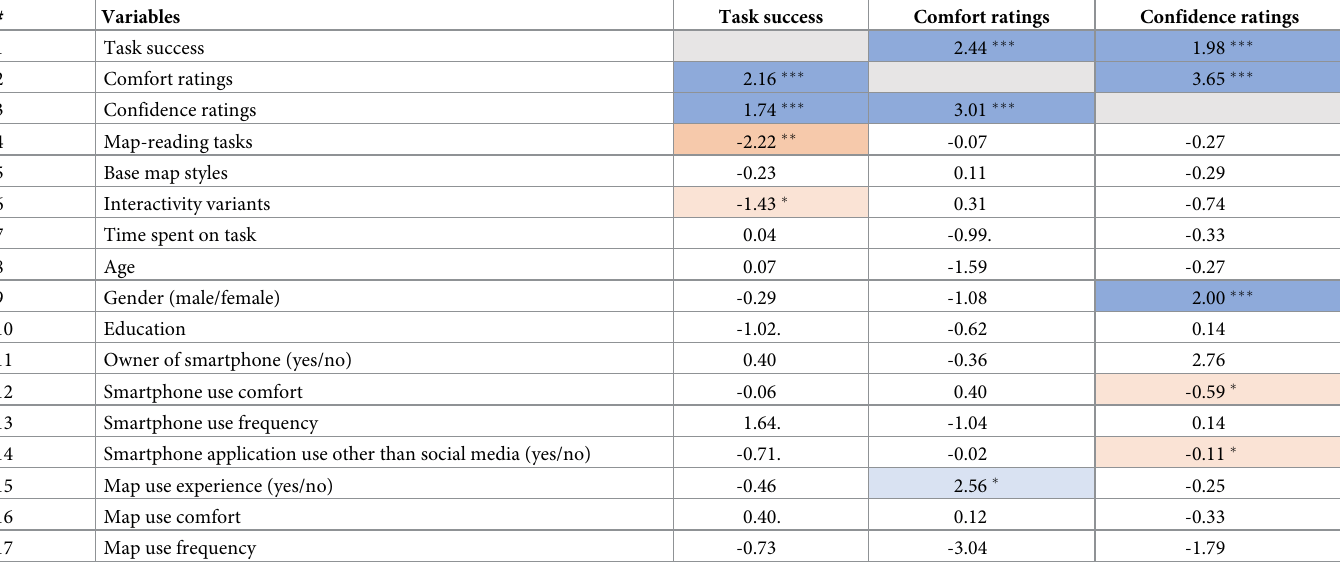
Table 6. Regression models with SBC and p-value with task success, comfort, and confidence ratings as the dependent variables (see S4–S6 Tables for odds ratios of each